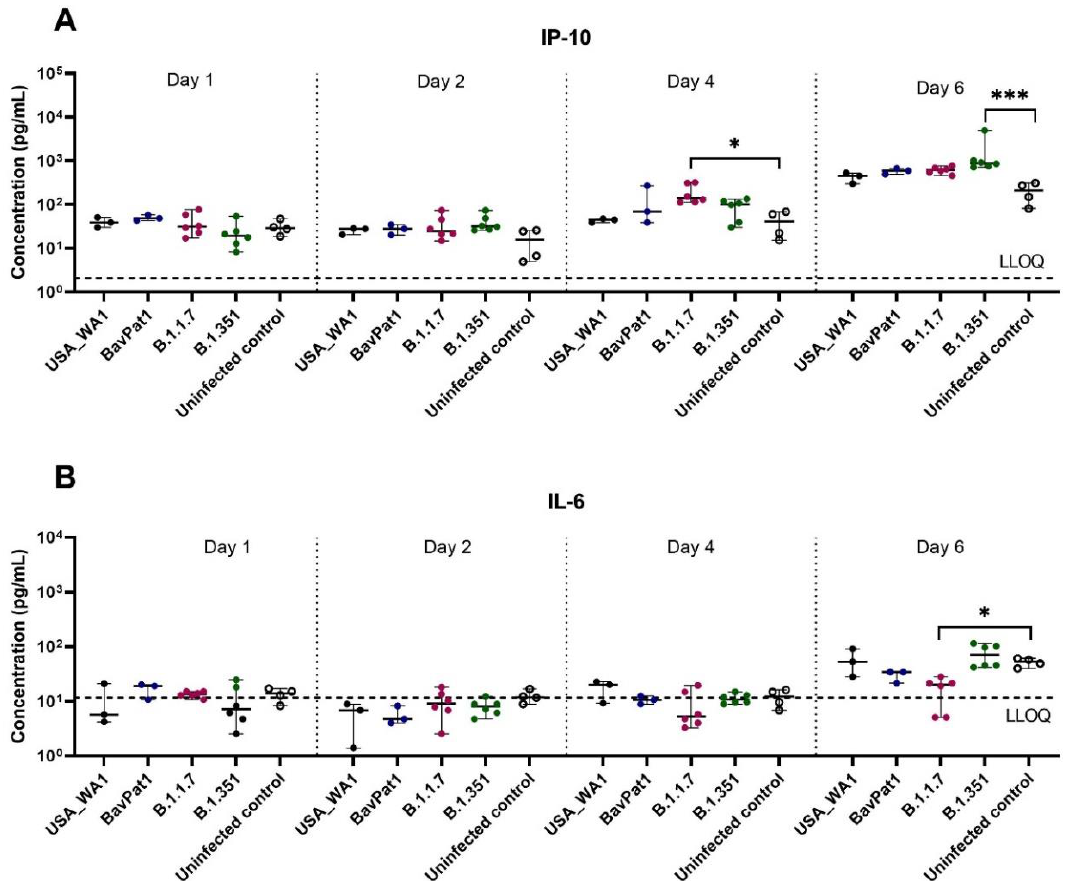
Figure 4. Cytokine and chemokine expression profiles after infection of HbAEC with different SARS-CoV-2 isolates. Production of ( A ) IP-10 or ( B ) IL-6 in HbAEC post-infection in the presence or absence of SARS-CoV-2. The dotted lines represent the lower limit of quantification (LLOQ). Statistical significance between the variants and uninfected control was calculated by Kruskal–Wallis with two-sided Dunn’s post hoc test. * p < 0.05, *** p < 0.001.